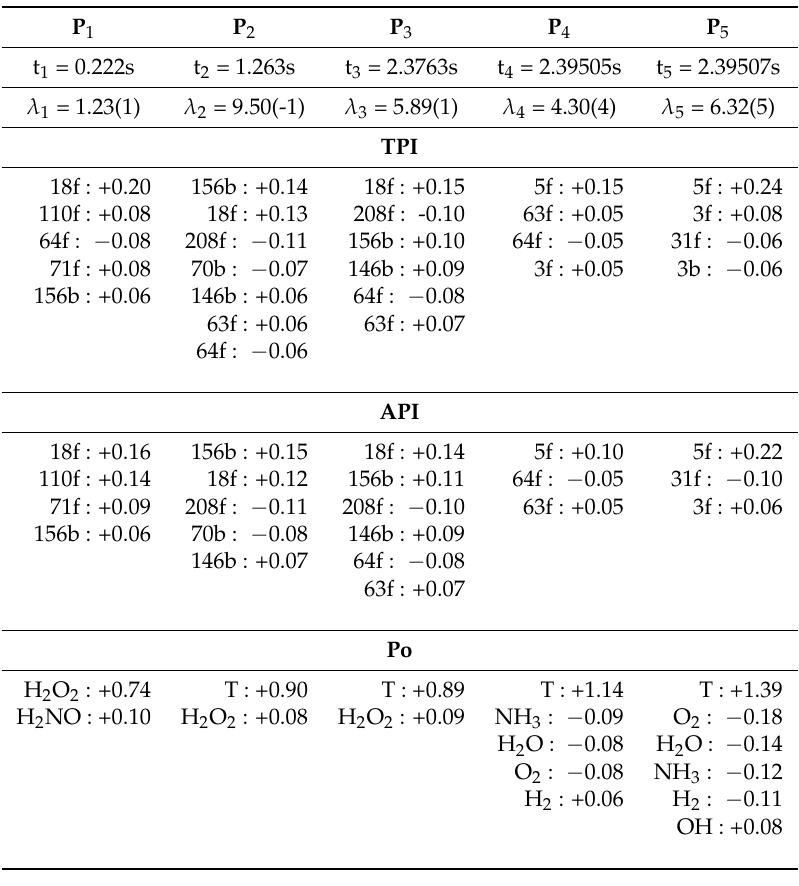
Table 2. The largest TPI, API and Po for the fast explosive mode of the pure NH 3 autoignition for the five points under consideration (see Figure 2); numbers in parenthesis denote powers of ten. Only contributions larger than 5% are